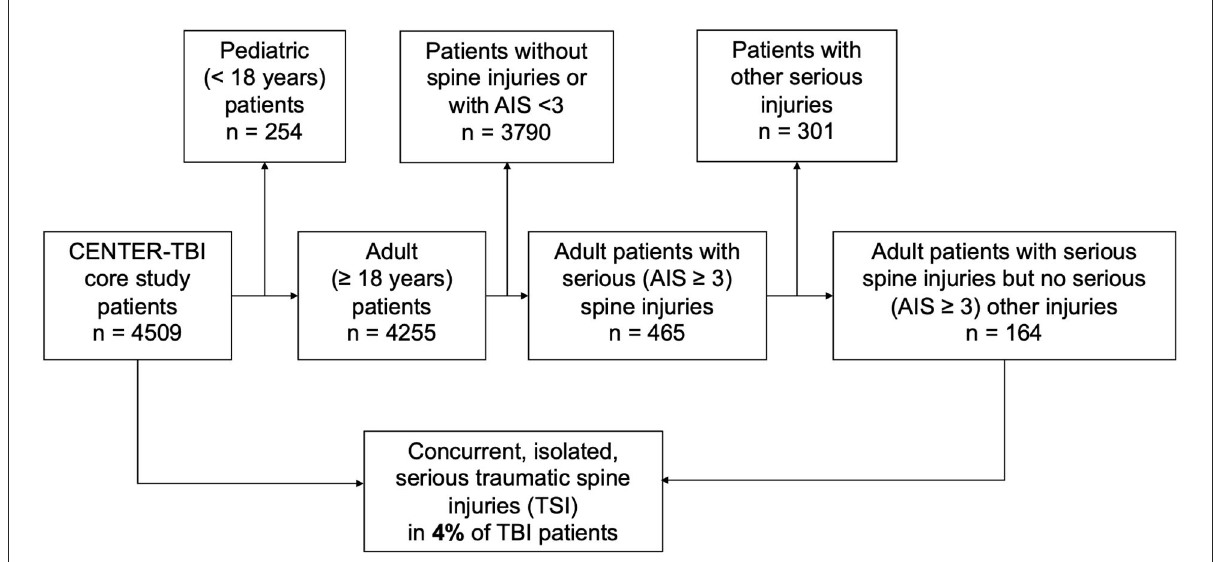
FIGURE1 Study design. Adult patients in the Collaborative European NeuroTrauma Effectiveness Research in Traumatic Brain Injury (CENTER-TBI) database were screened. Patients with poly-trauma were excluded. Only patients sustaining TBI along with isolated traumatic spine injury (TSI) without the presence of further trauma were included in the analyses.